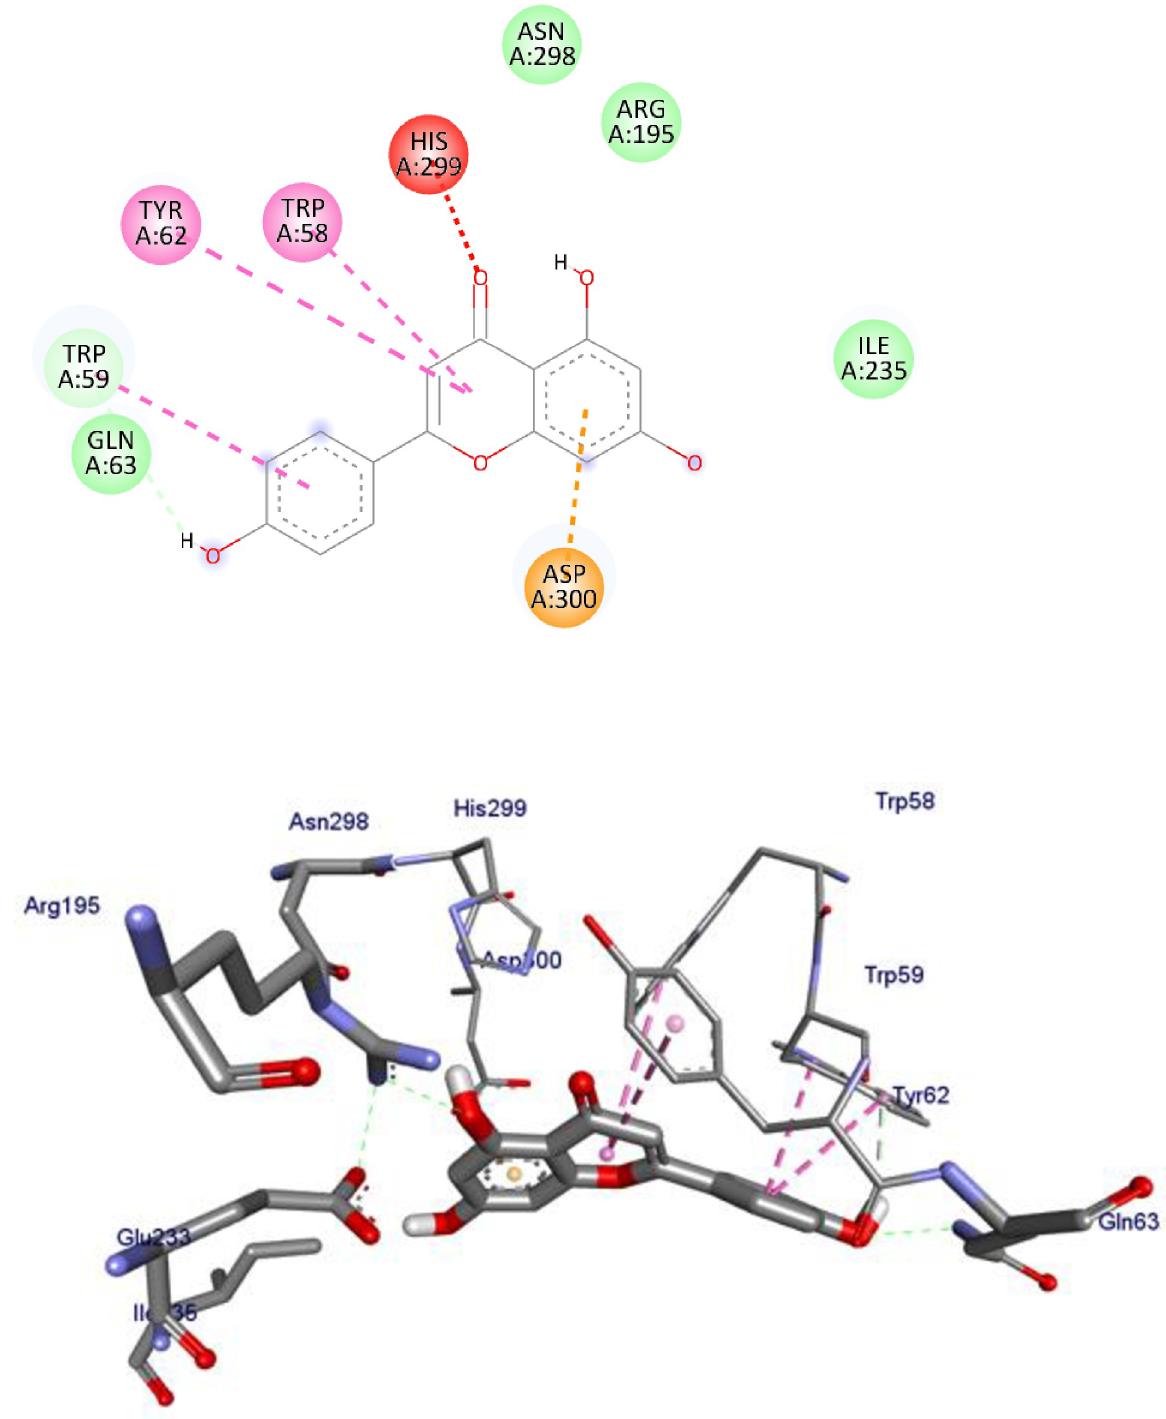
Fig 3. 2D (upper panel) and 3D (upper panel) representations of the binding modes of compounds apigenin to Human α -amylase (PDB ID: 4W93).